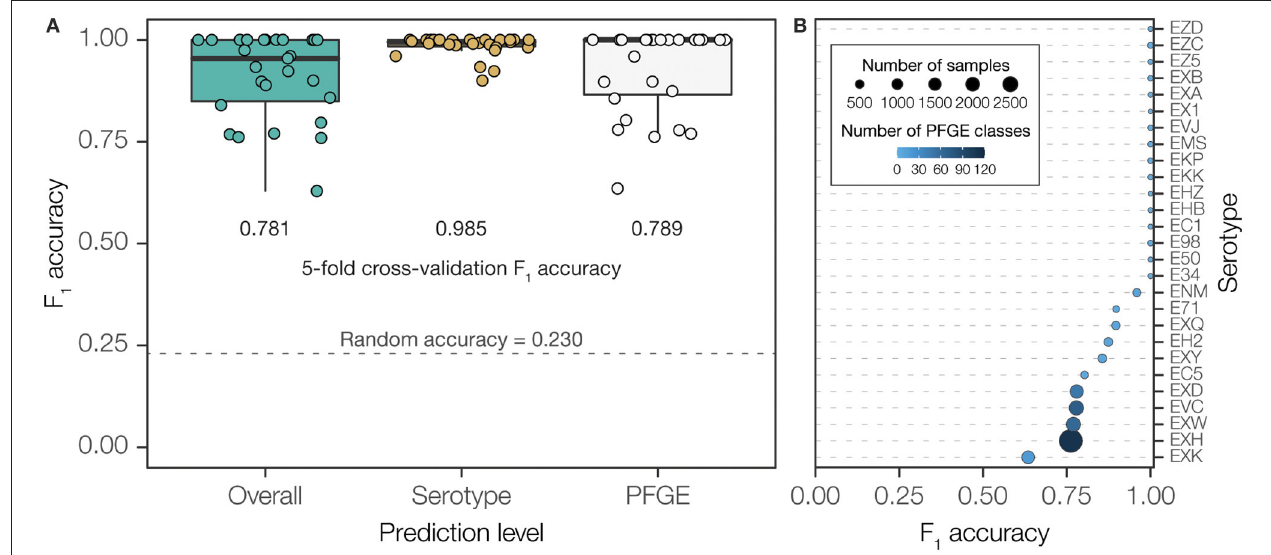
FIGURE 4 | Overall performance of PFGE classifier using final, two-step prediction model measured by F 1 accuracy. (A) PFGE pattern prediction performance measured by F 1 accuracy across serotypes. Bubble size scales with number of isolates within a serotype while color shade darkens with number of unique PFGE classes within a serotype. (B) Classification performance measured in F 1 accuracy when using each model independently and combined. F 1 accuracy of a classifier using random guessing was calculated to demonstrate a baseline expected performance without training.